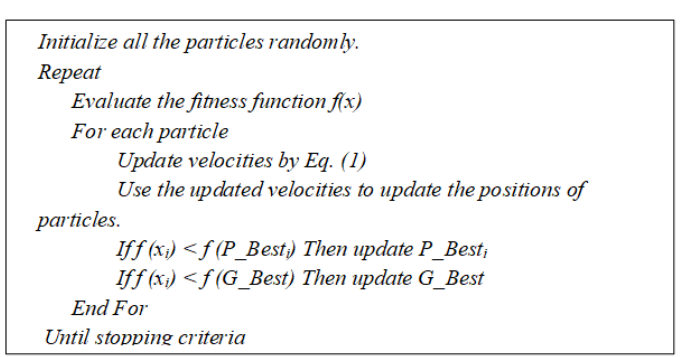
Figure 2. Pseudo code of